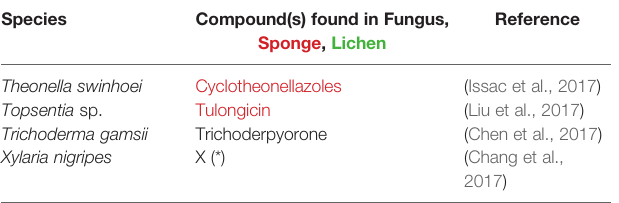
TABLE 3 | Some examples of compounds isolated from fungi, sponges and